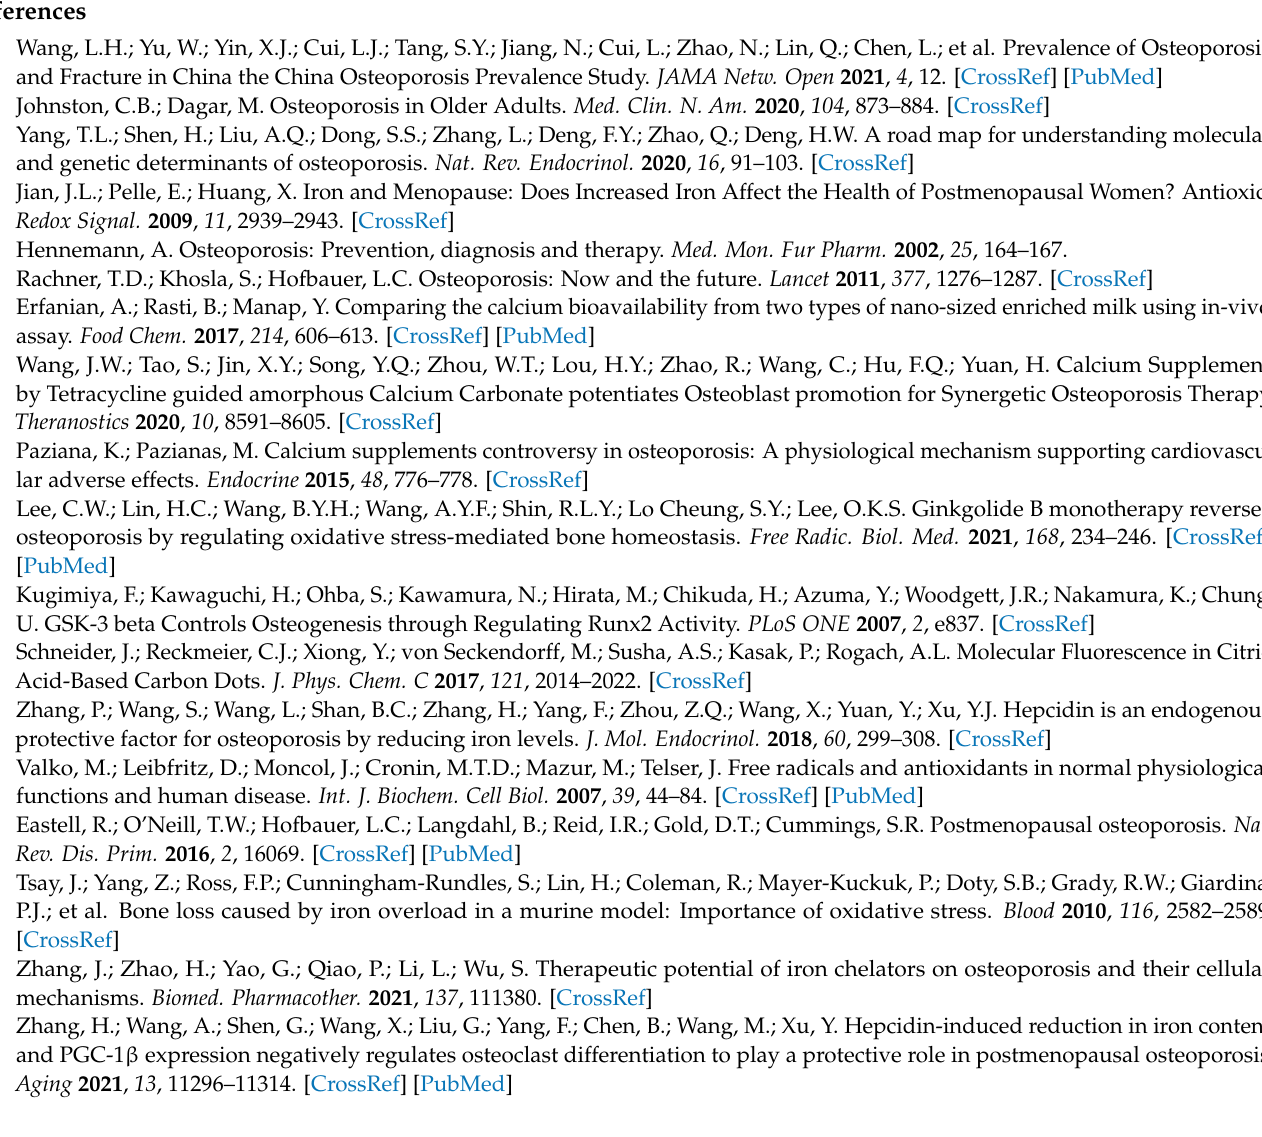
Figure S2: Biosafety detection of AOCDs:Ca; Table S1: Primer sequences for Real-Time